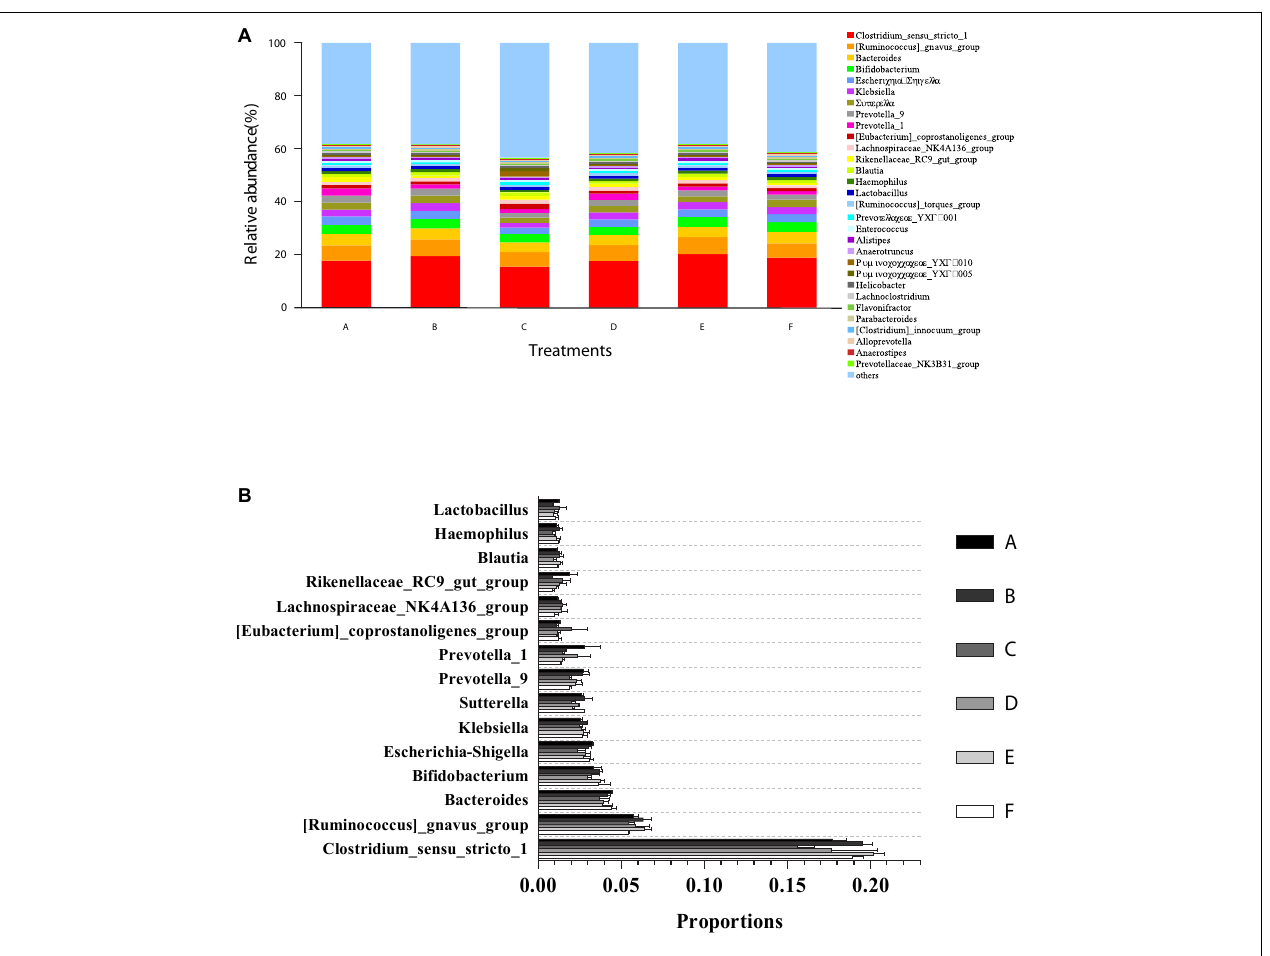
FIGURE 5 | Relative abundances of dominant genera and comparison with bacterial abundances in the intestine at the genus level. (A) Relative abundances of dominant genera (top 30) from all classifiable sequencing data. Unclassified genera with relative abundances lower than 1% were assigned as “others.” (B) The abundance comparison with 15 most abundant genera in shrimp intestine among all the treatments. Data are expressed as mean ± SEM from triplicate